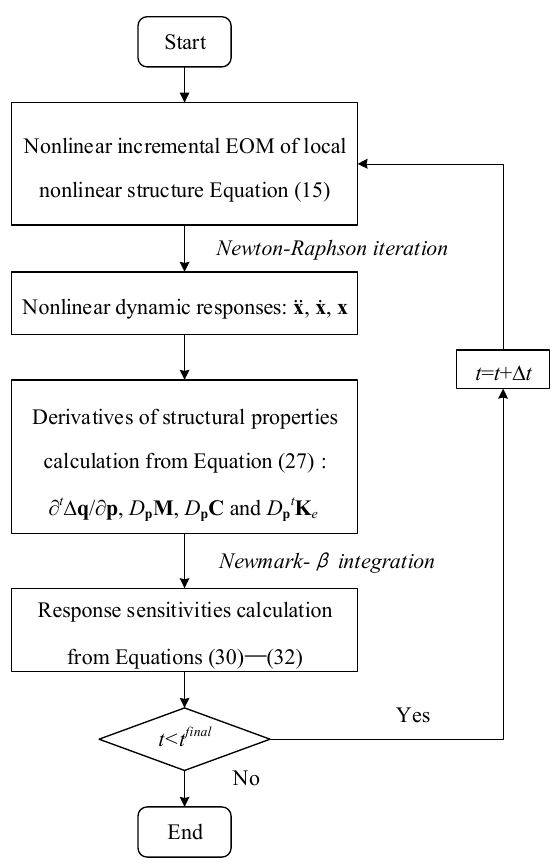
Figure 1. Flow chart of transient response sensitivity analysis.